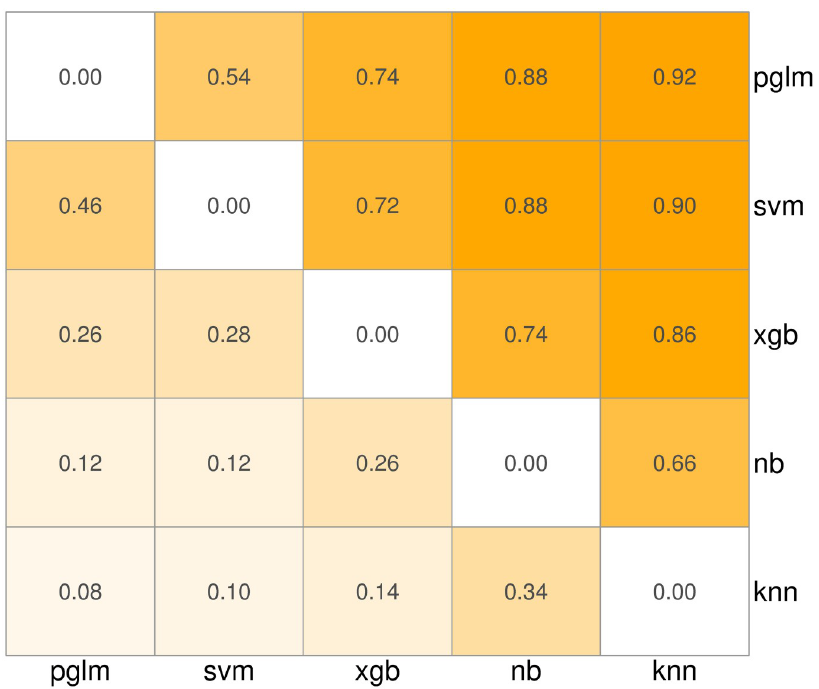
Fig 1. Ranking machine learning algorithms based on AUC. Numeric values indicate the fraction of times the row algorithm has higher classification performance than the column algorithm. pglm: elastic net penalized logistic regression, svm: support vector machine with radial basis function, xgb: gradient boosted trees, nb: naive Bayes, knn: k-nearest neighbors.